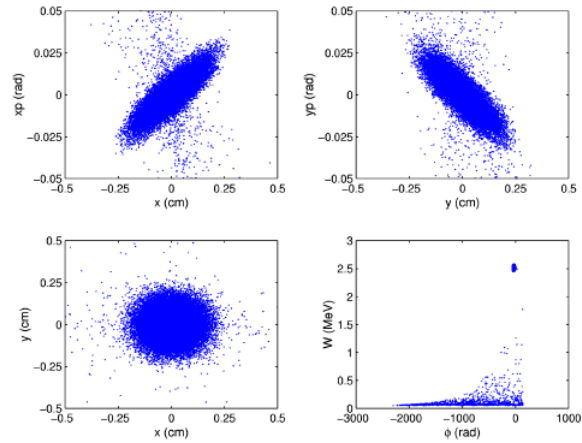
FIG. 2. (Color) Transverse and longitudinal phase-space projec- tions of the beam at the MEBT entrance. The scattered particles are low-energy particles, lost immediately in the MEBT. The number of macroparticles is 87 000. This beam is used through- out the study. The normalized x ( y ) rms emittance is 0.36 (0.28) p mm